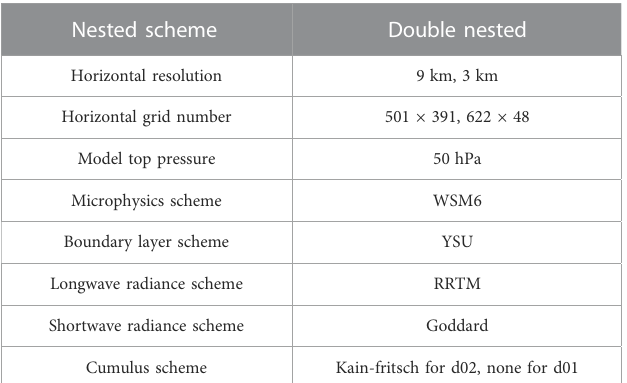
TABLE 1 Model con fi gurations.